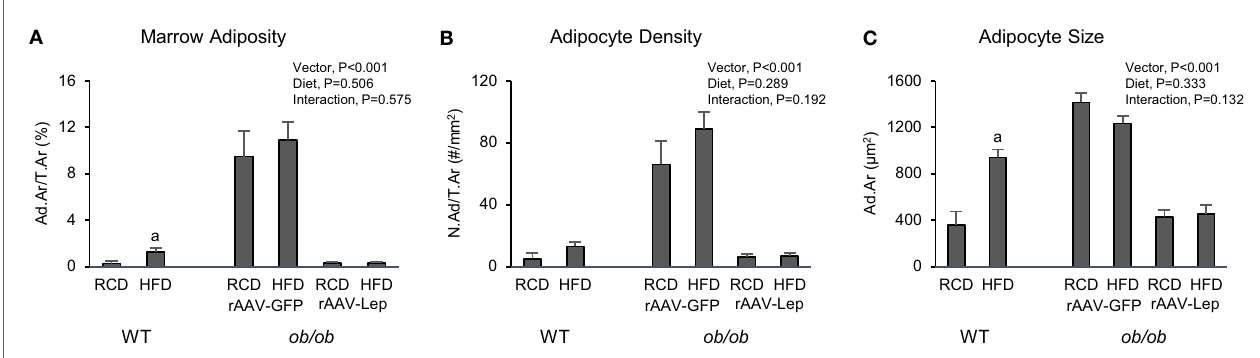
FigUre 3 | effects of high-fat diet and raaV-lep pretreatment and high-fat diet on bone marrow adiposity (a), adipocyte density (B), and adipocyte size (c) in distal femur metaphysis in male WT and ob/ob mice, respectively . RCD, regular control diet. HFD, high-fat diet. Data are mean ± SE ( n = 3–9/ group). a Different from RCD within WT, P < 0.05.